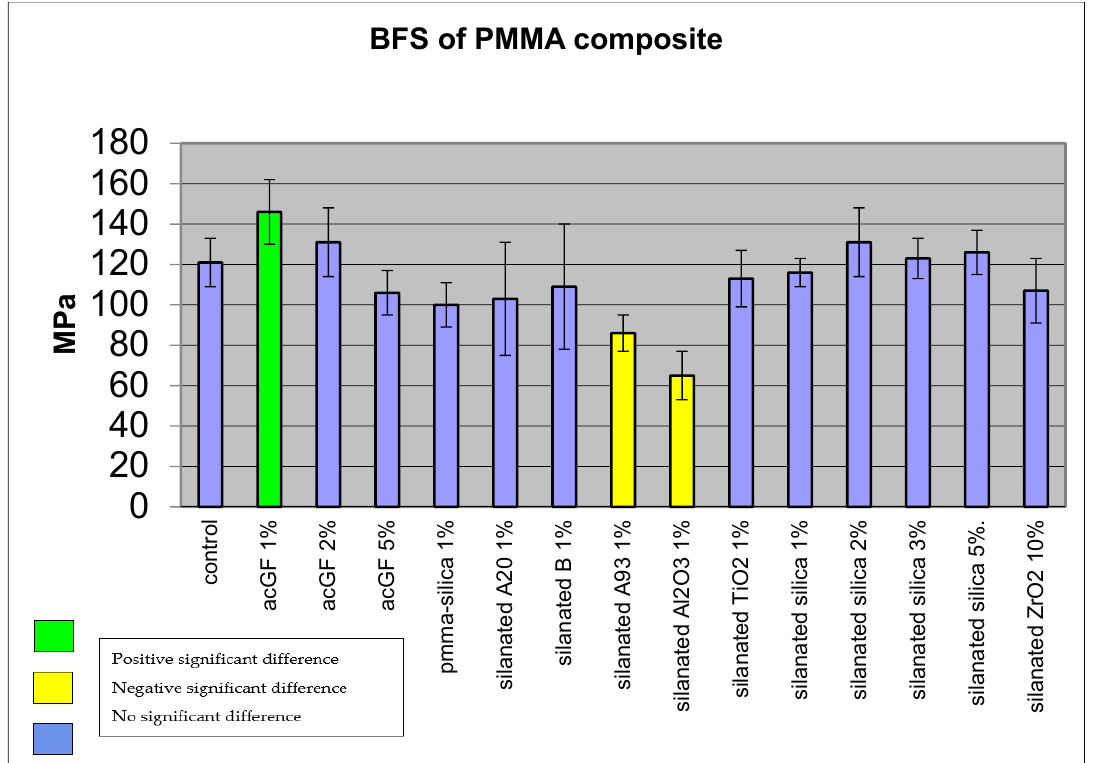
Figure 12. Comparison of biaxial flexural strength of filler added resin and plain resin. Table 1. Comparison of biaxial flexural strength of filler added resin and plain resin, MMA. * Statistically significant compared to the control group.